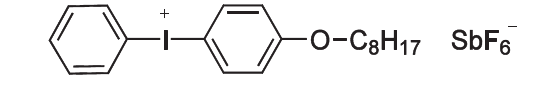
Figure 26. Structure of an iodonium photo initiator